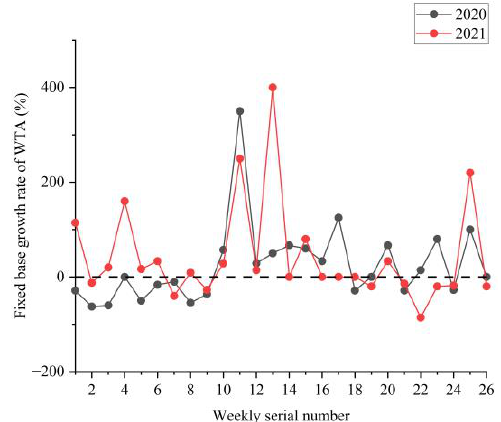
Figure 11. Fixed base growth rate of WTA.